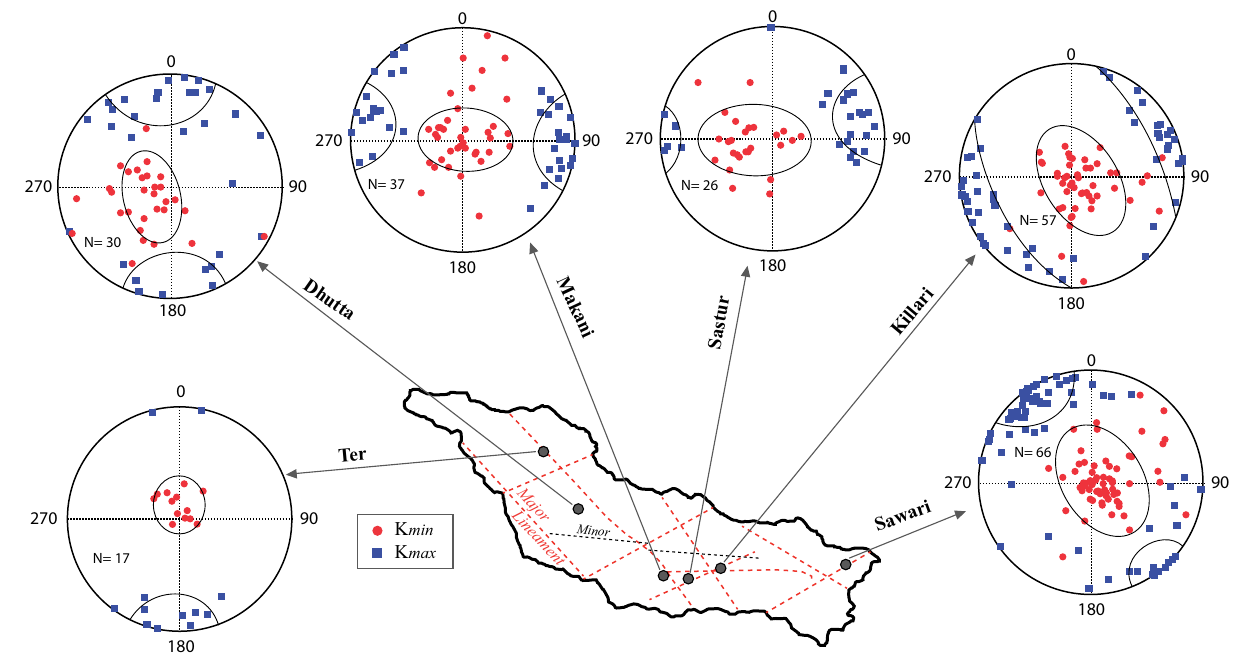
Figure 6. Equal area projections (lower hemisphere) of the directions of K max (solid squares) and K min axes (open circles) of AMS ellipsoids. The spreads in orientations of K max and K min axes are qualitatively indicated in the stereograms. The lineament pattern along the Tirna River basin also shown (dashed Sastur sections. In P ′ versus T plot, the Sawari data mostly plot in oblate field (85%) and a few in prolate fields (15%). The P ′ values for these samples show higher range of variation of 1.03 (Fig. 7d).